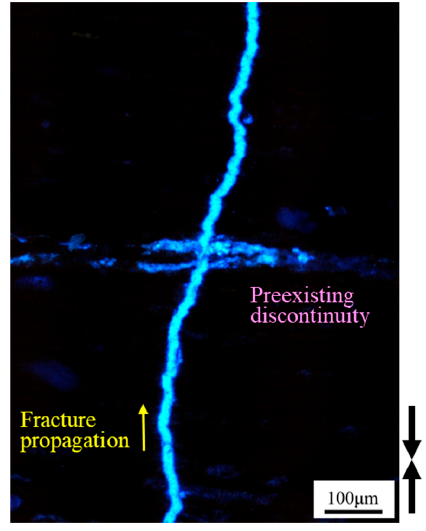
Figure 6. Observation of an induced fracture cutting straight through a preexisting discontinuity in the Eagle Ford specimen. The pair of black arrows next to the figure represents the loading direction. The preexisting discontinuity was impregnated by the resin in short segments.